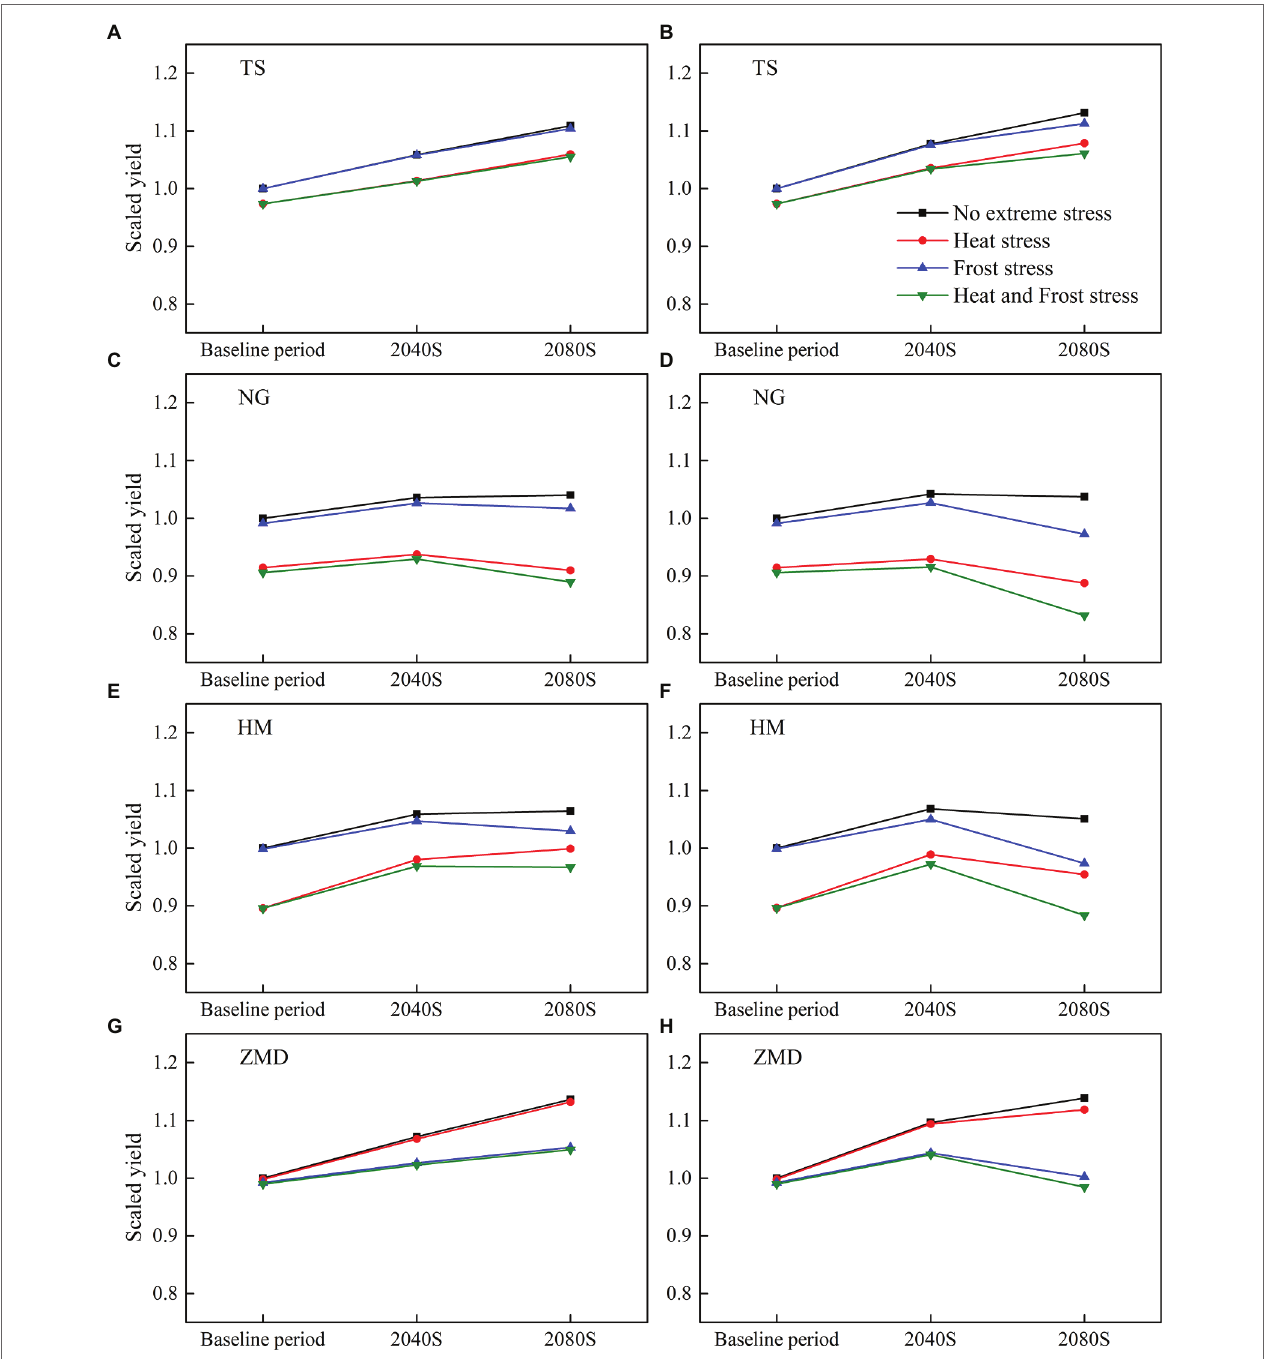
FIGURE 4 | Simulated multi-Global Climate Model (GCM) ensemble mean yield for the baseline and two future periods (2040S and 2080S) under SSP245 (A,C,E,G) and SSP585 (B,D,F,H) without and with the effect of extreme temperature stress (i.e., heat and frost stress). All the yields have been normalized by historical yield without the effect of extreme temperature